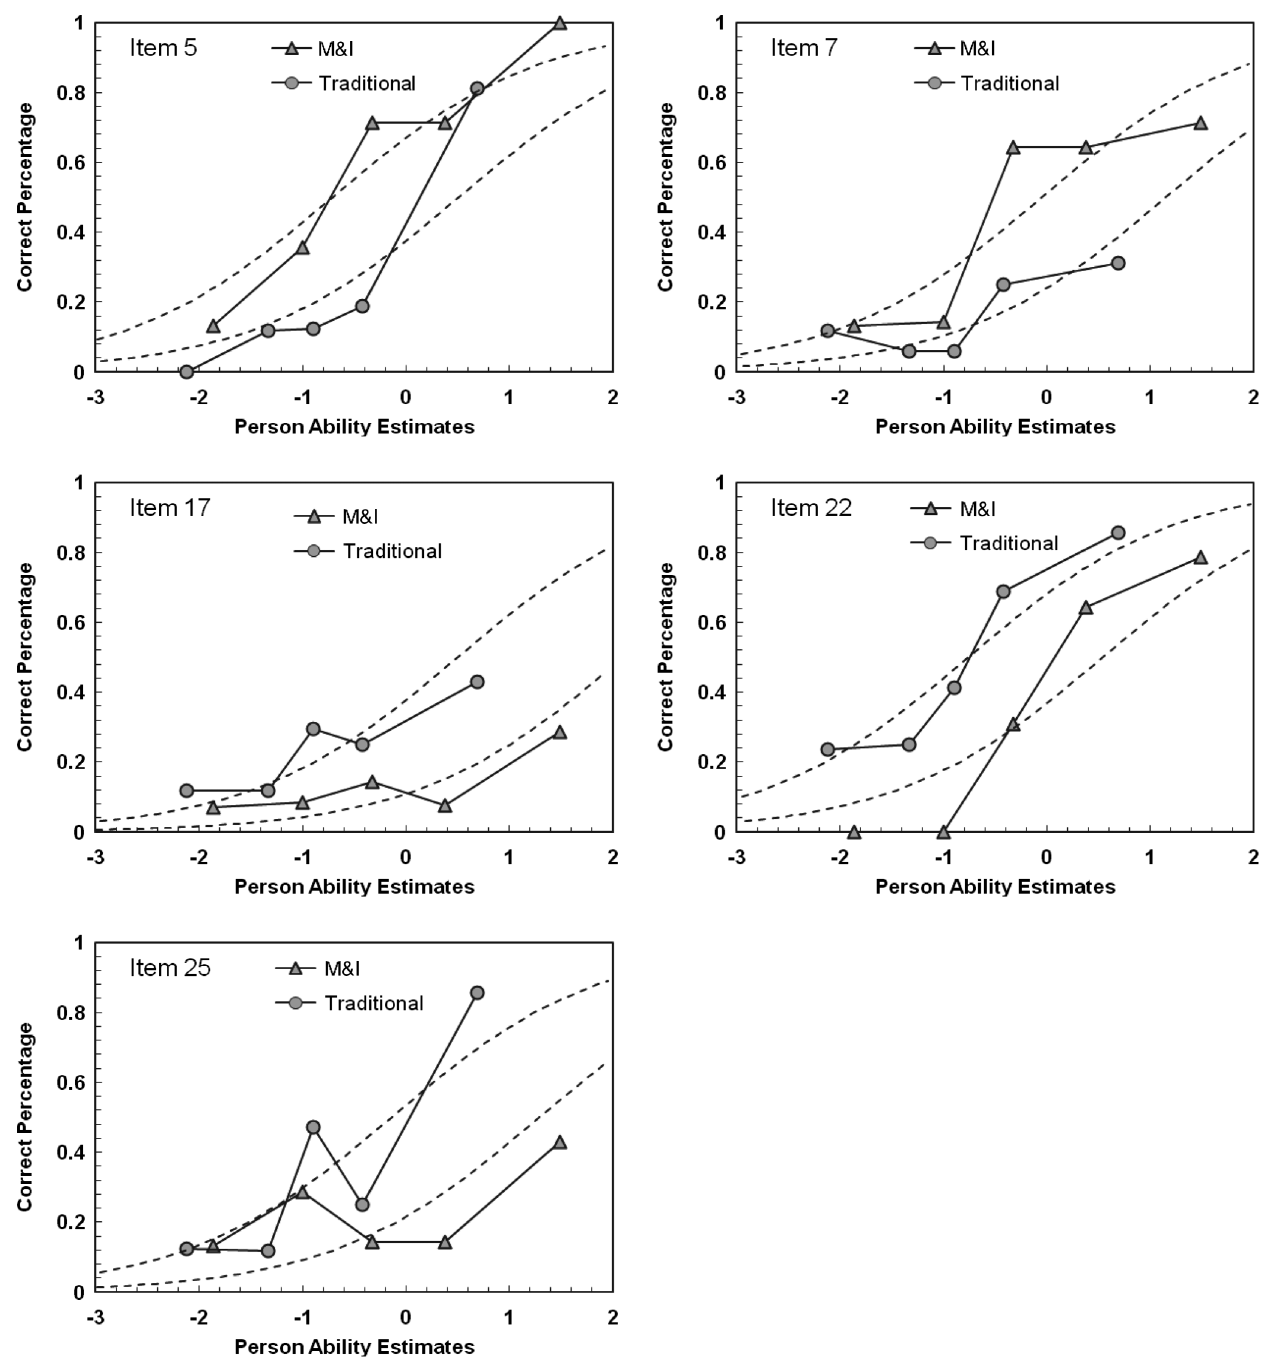
FIG. 5. Item characteristic curves (showing proportion of correct responses as a function of person ability) for BEMA items with DIF. Solid lines are empirical results based on the data from the traditional and M&I courses respectively, dashed lines are modeled